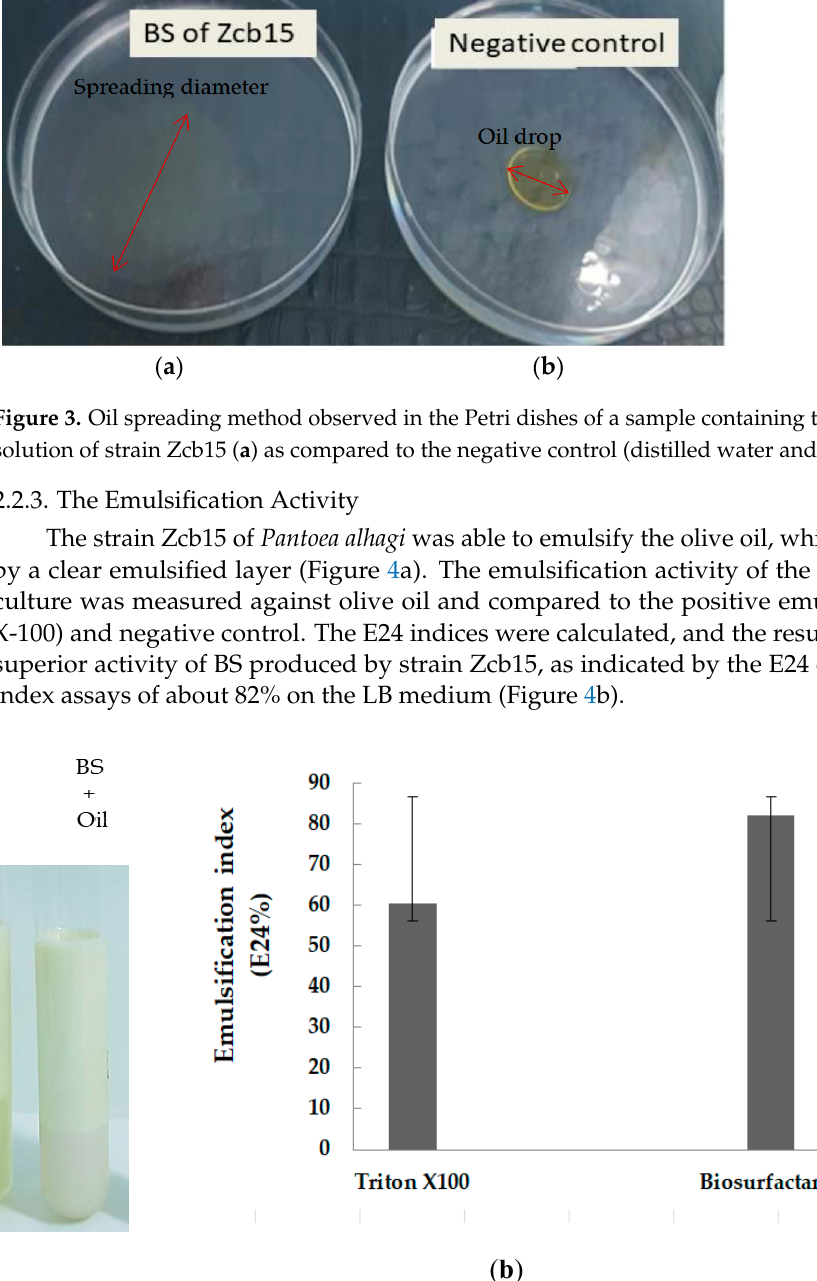
Figure 2. Hemolysis test results confirmed the presence of biosurfactants of the glycolipid family, as shown by the clear zone around the bacteria colony of Pantoea alhagi strain Zcb15.